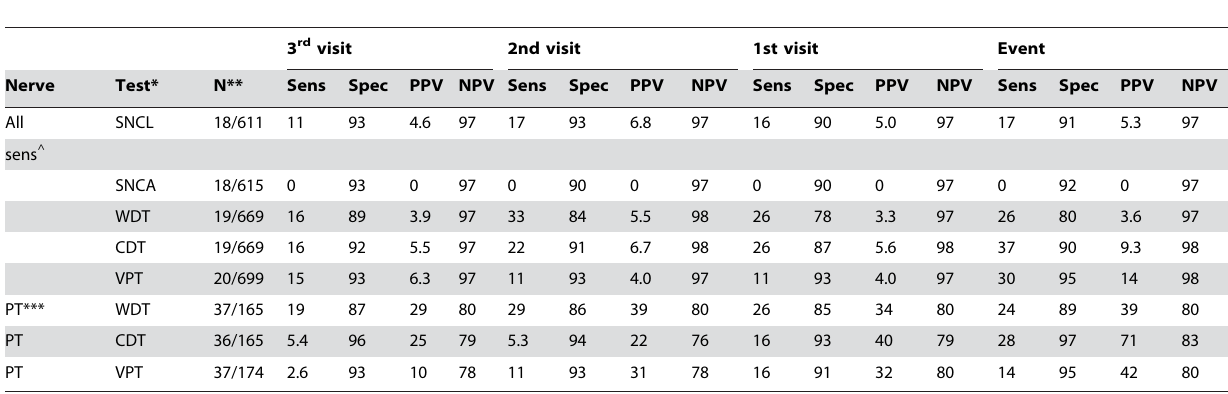
Table 5. Predictive value of new impairment detected by quantitative sensory testing and sensory nerve conduction testing in predicting new impairment by monofilament test at 12, 8 and 4 weeks before the event, in five sensory nerves in the INFIR Cohort